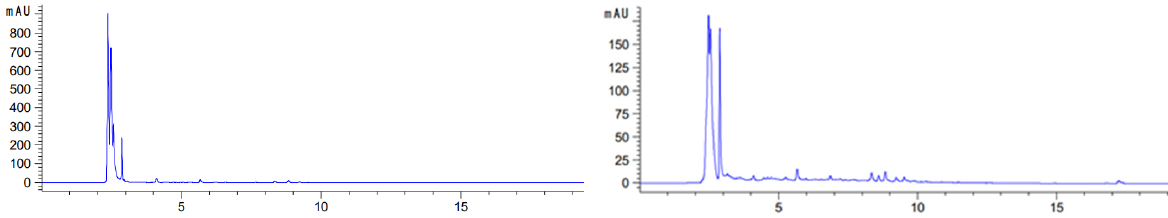
Figure 2. Polyphenolic profiles of burger meat product ( left ) and burger vegetarian product ( right ).